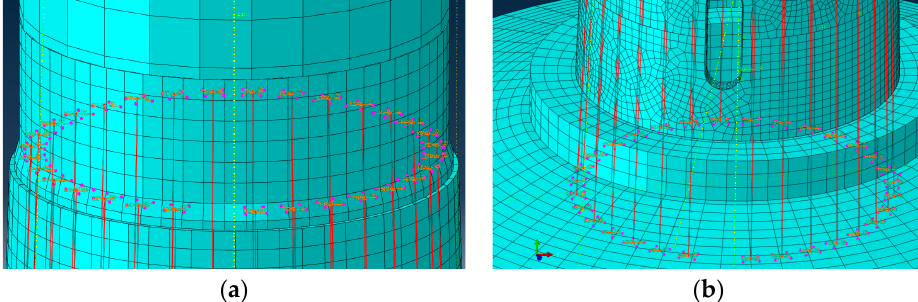
Figure 4. Interaction of prestressed anchor cables. ( a ) MPC constraint of conversion section and prestressed anchor cables; ( b ) MPC constraint of foundation and prestressed anchor cables.